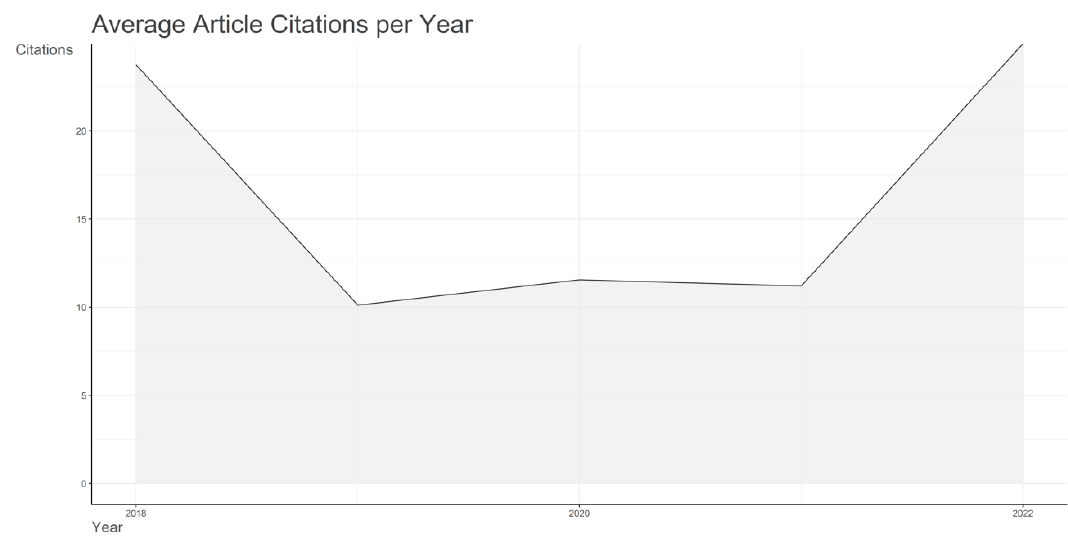
Figure 4. Average citation per year, performed with Biblioshiny version 4.0.